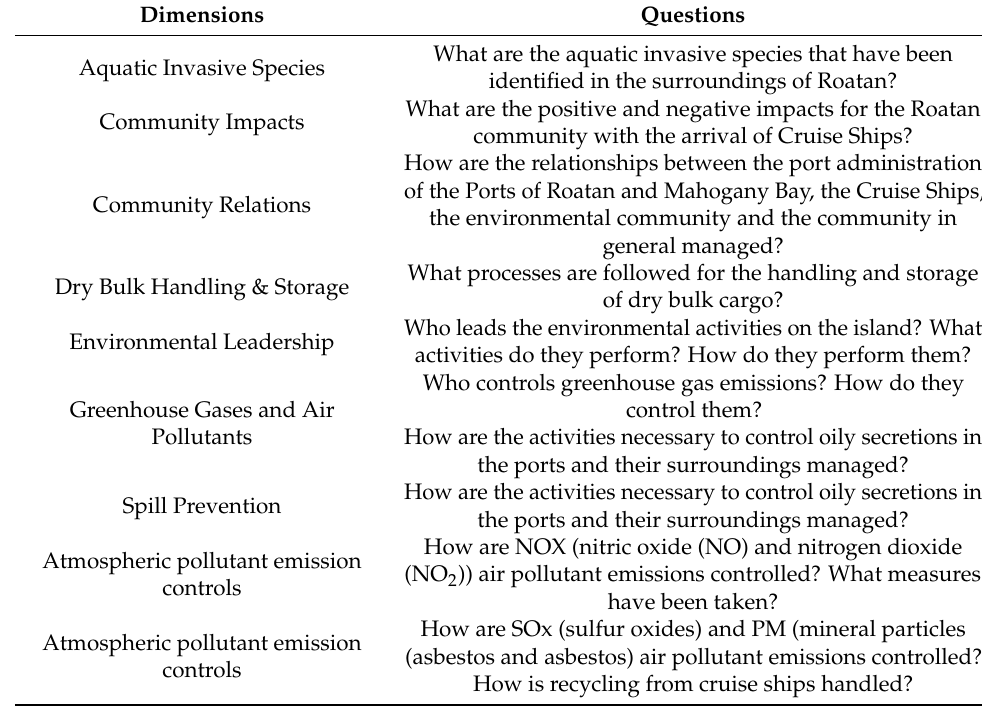
Table 2. Dimensions and